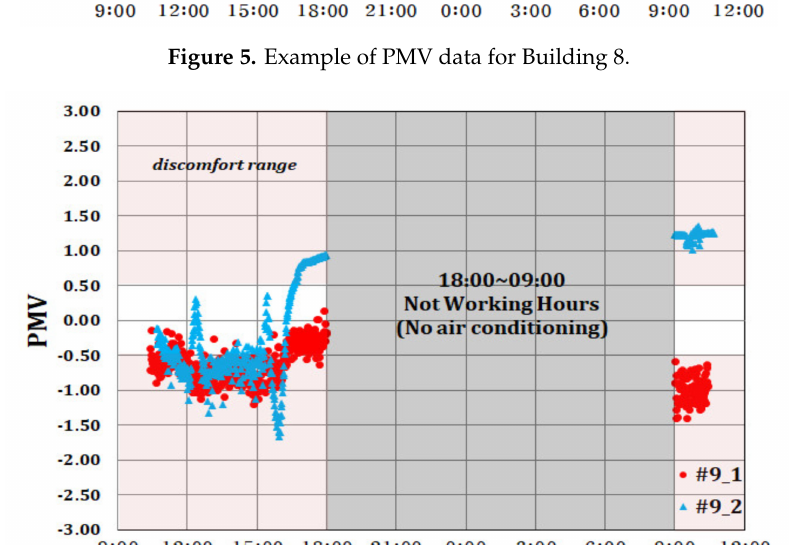
Figure 6. Example of PMV data for Building